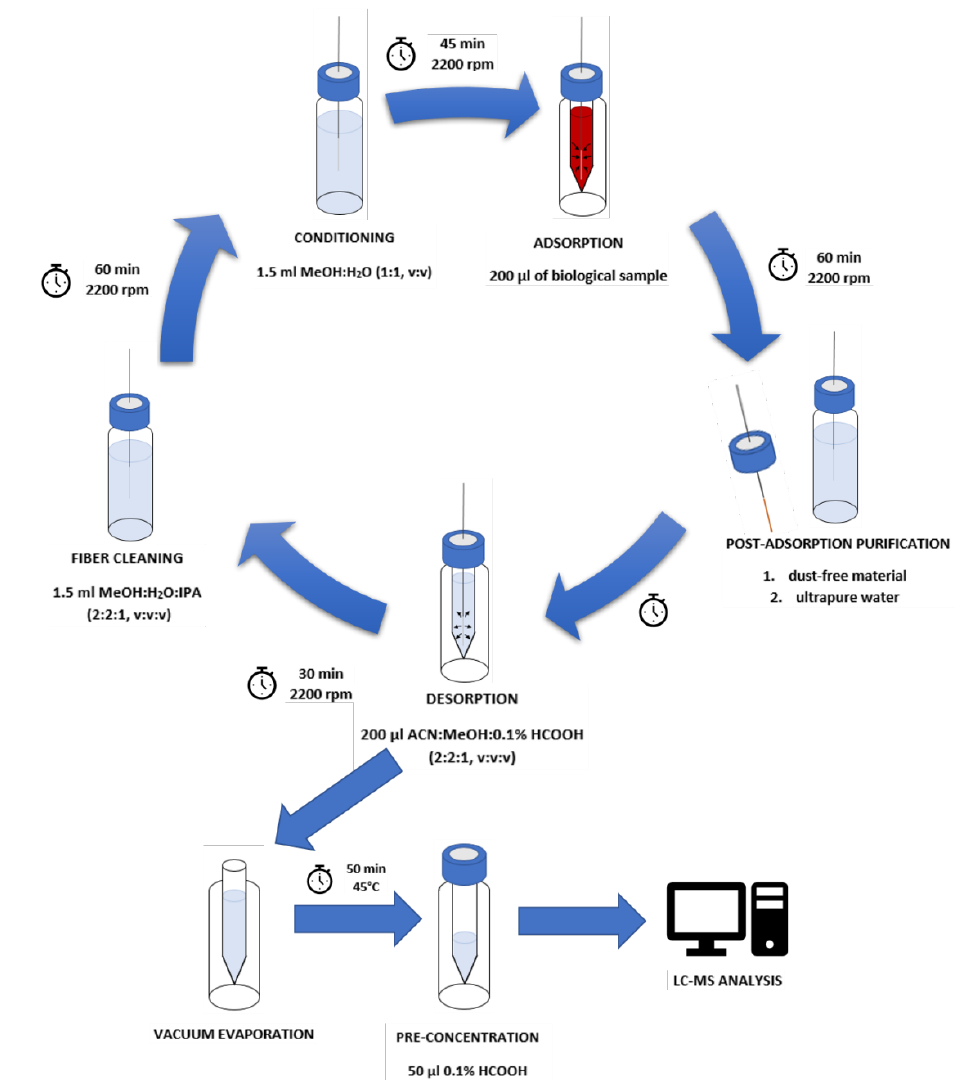
Figure 5. Procedure of the DI-SPME method of sample preparation and fiber cleaning.